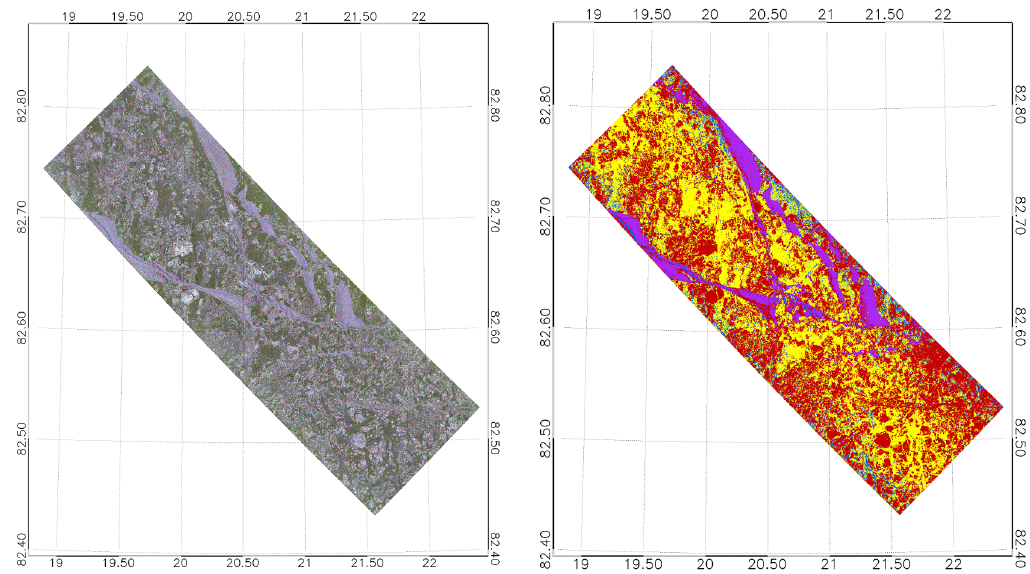
Figure A8. ( Left ) Geocoded Pauli RGB composite (Red: HH-VV Green: HV+VH Blue: HH+VV) of the TS-X acquisition on 23 April 2015, frame 3; ( Right ) ice classification. Blue: open water/nilas (OW), purple: young ice (YI), yellow: first year ice (SFYI), red: rough first year ice/multi-year ice (RFYMYI).